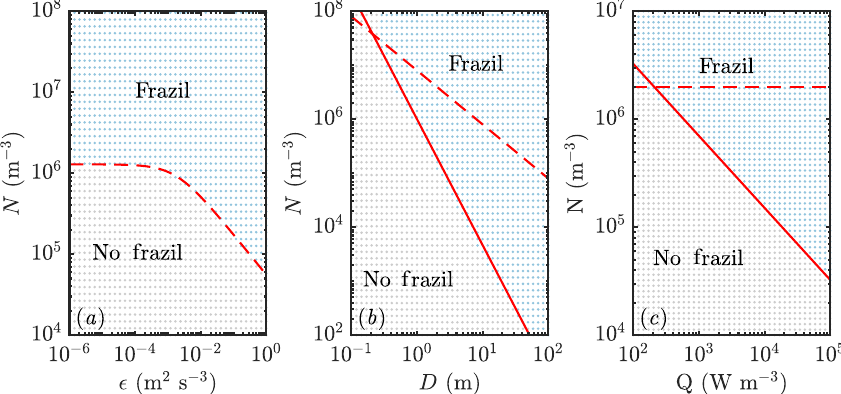
Figure 4. Regime diagram showing how the parameters of the system affect the likelihood of a frazil explosion (coloured blue and labelled “frazil” in each panel) or collapse of the ice population by gravitational settling (coloured grey and labelled “no frazil”). Each dot represents a separate numerical simulation. Increased (a) turbulent intensity (cid:15) , (b) mixed-layer depth D , and (c) cooling rate Q all promote frazil explosions. Apart from the panels in which they are varied, the parameters used are as in Fig. 3. The dashed and solid curves show the predictions of scaling analysis described in the main text. The dashed curves correspond to Eq. (18) and the solid curves to Eq. (22). Note that in panel (a) these equations give the same predictions, so only one curve is